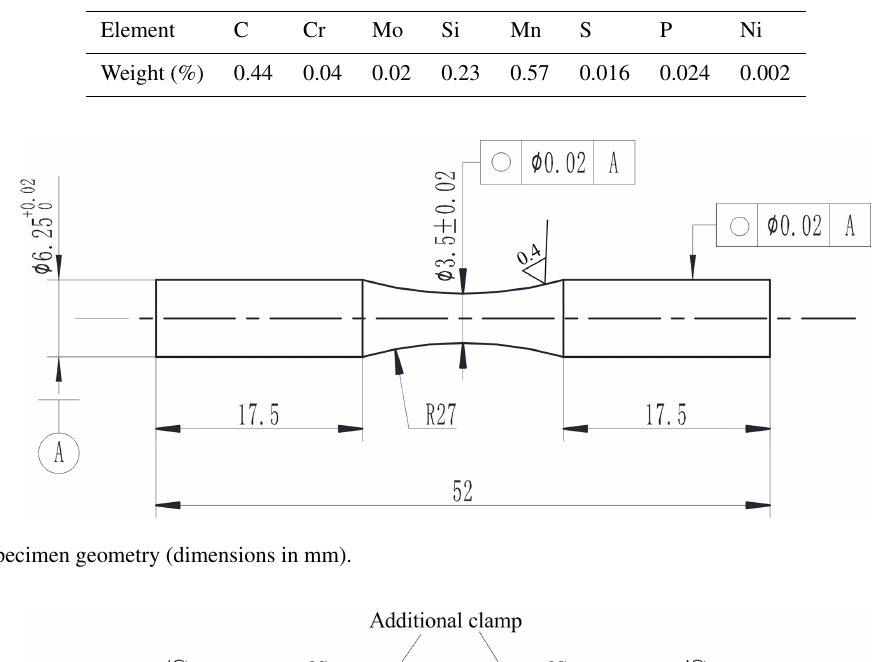
Table 1. Chemical composition of the medium-carbon steel.